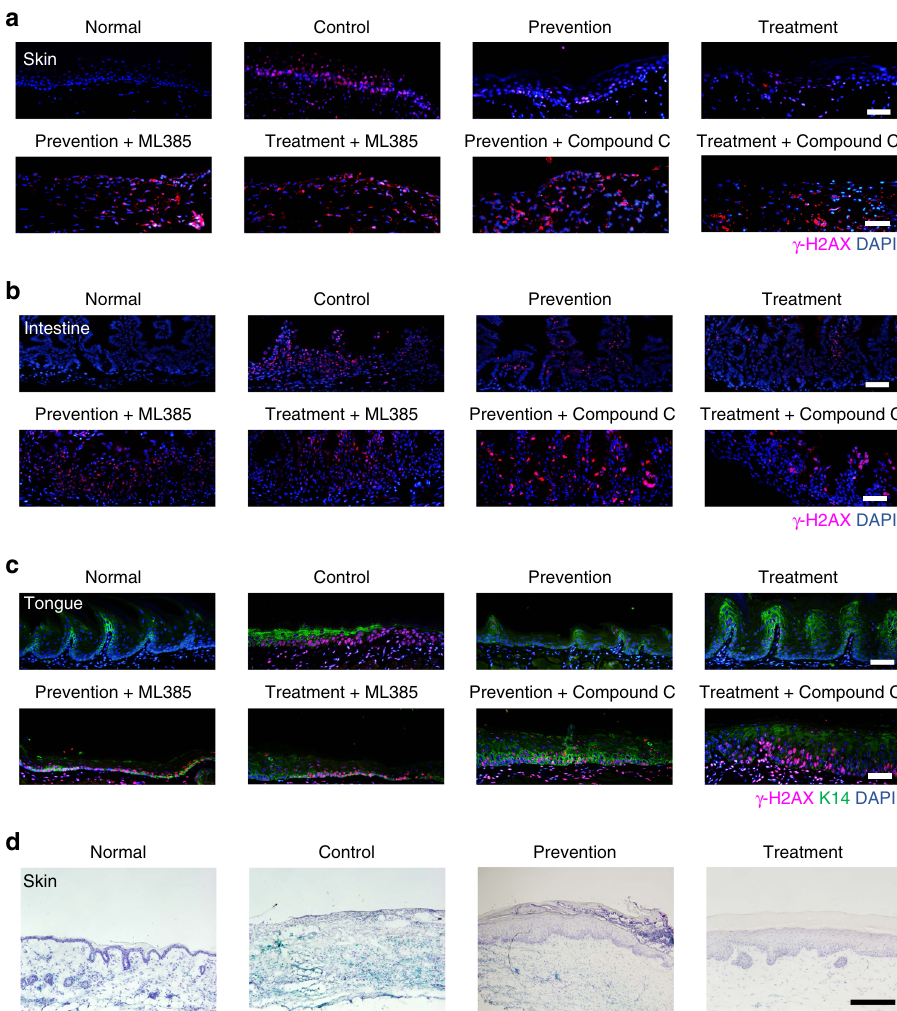
Fig. 4 Cordycepin prevents DNA damage and cell senescence in vivo. a – c Representative immuno fl uorescence pictures and quanti fi cation of γ -H2AX in rat skin, mouse intestine and mouse tongue sections from normal animals and irradiated animals 35 days after irradiation, respectively. Basal progenitor marker cytokeratin 14 (K14) was used to label the basal progenitor layer of tongue. The γ -H2AX positive nuclei was calculated using Image J software. d Representative SA- β -gal staining in skin tissues from normal rats and irradiated rats 35 days after radiation. ML385: NRF2 inhibitor; Compound C: AMPK inhibitor. Bars represent 50 μ m ( a – c ), 200 μ m ( d